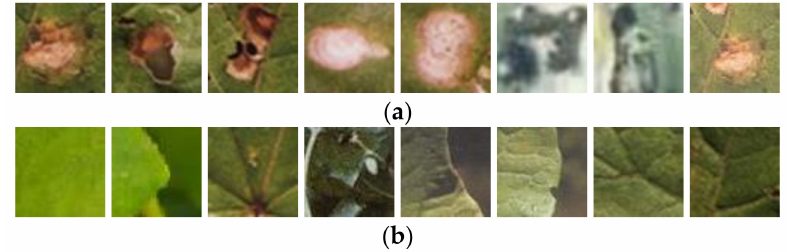
Figure 9. Training samples. ( a ) positive training sample; ( b ) negative training sample.